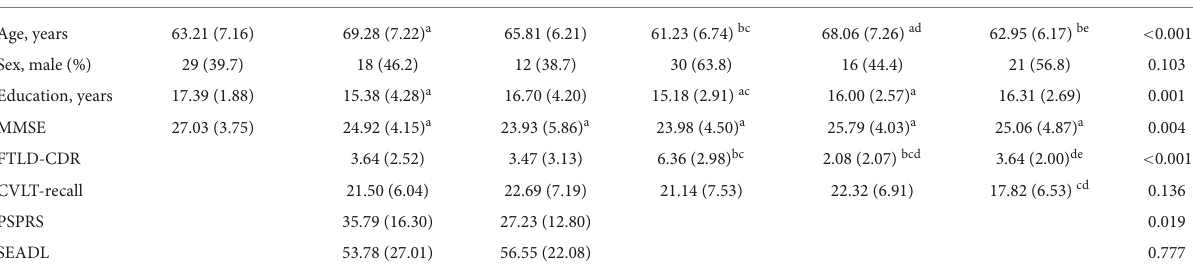
TABLE 1 Participant demographics and clinical